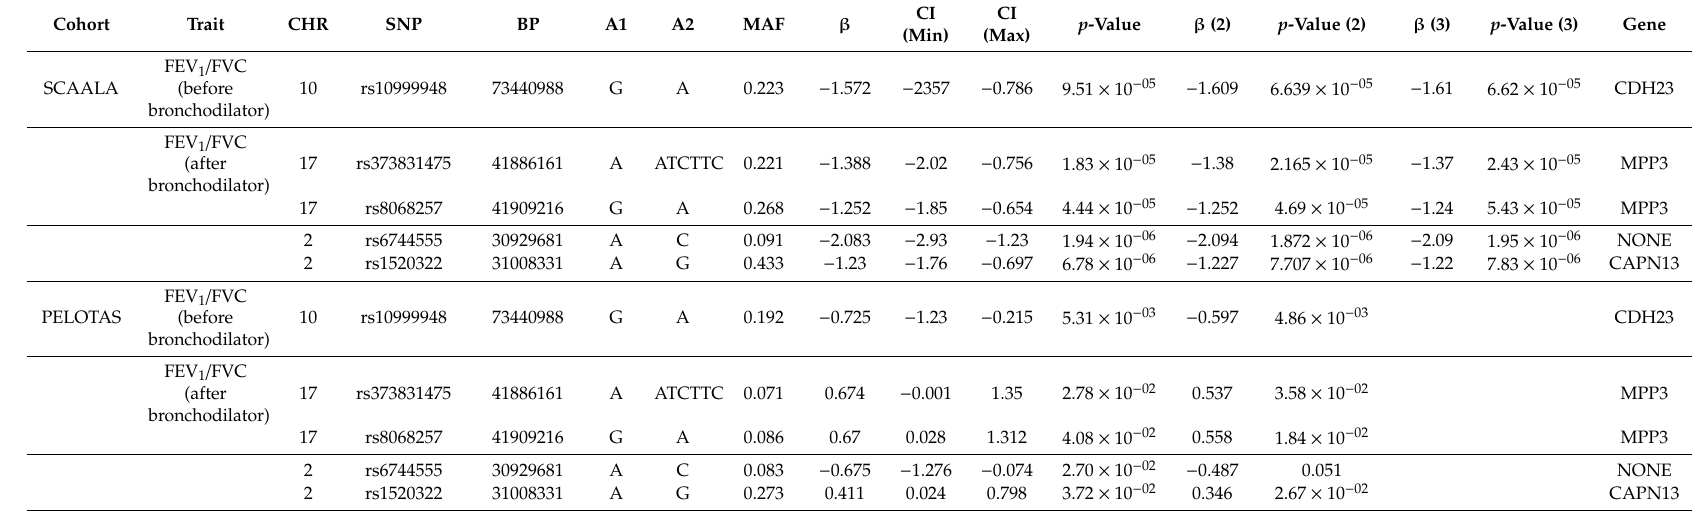
Table 2. Fine mapping significant associations for %FEV 1 / FVC ratio identified through imputed variants from 1000 Genomes phase 3 next. Analysis obtained by linear regression showing only the associated common SNPs for the SCAALA and 1982 Pelotas birth cohorts. Cohort